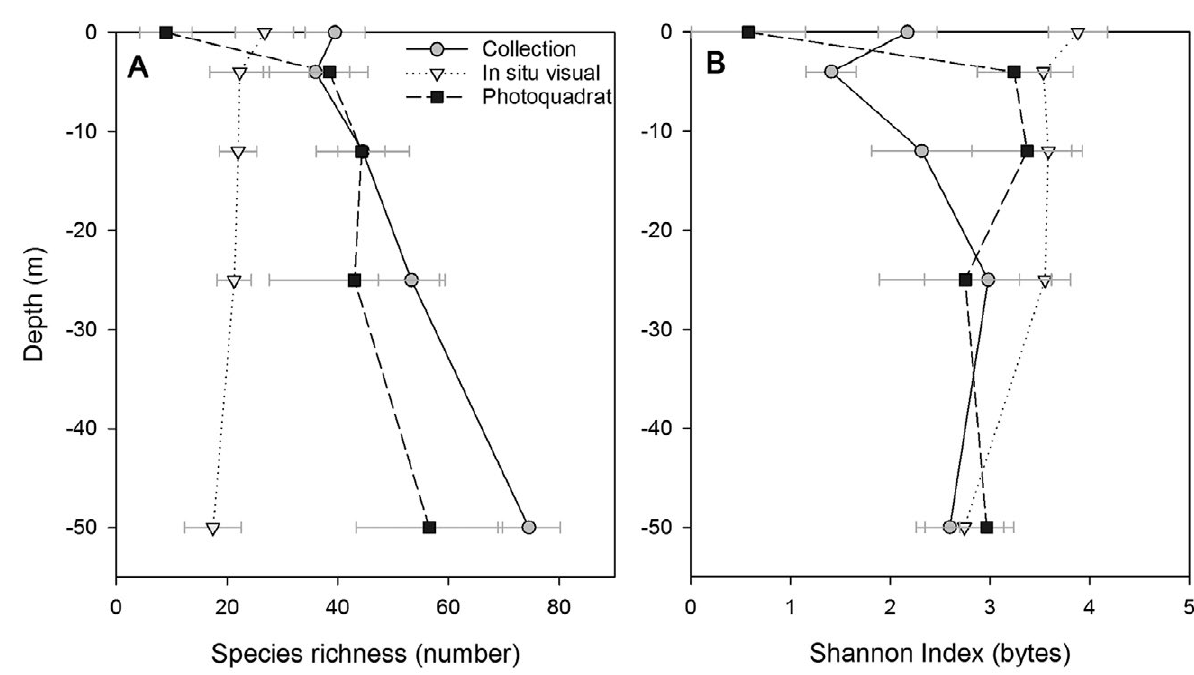
Fig. 2. – Average number of species (A) and species diversity (B) along the depth gradient. Table 1. – Quantitative similarity index (Kulczynski Index) between samples. Estimates show mean ± sd. Group size indicates the number of replicates per group used to calculate the similarity index.